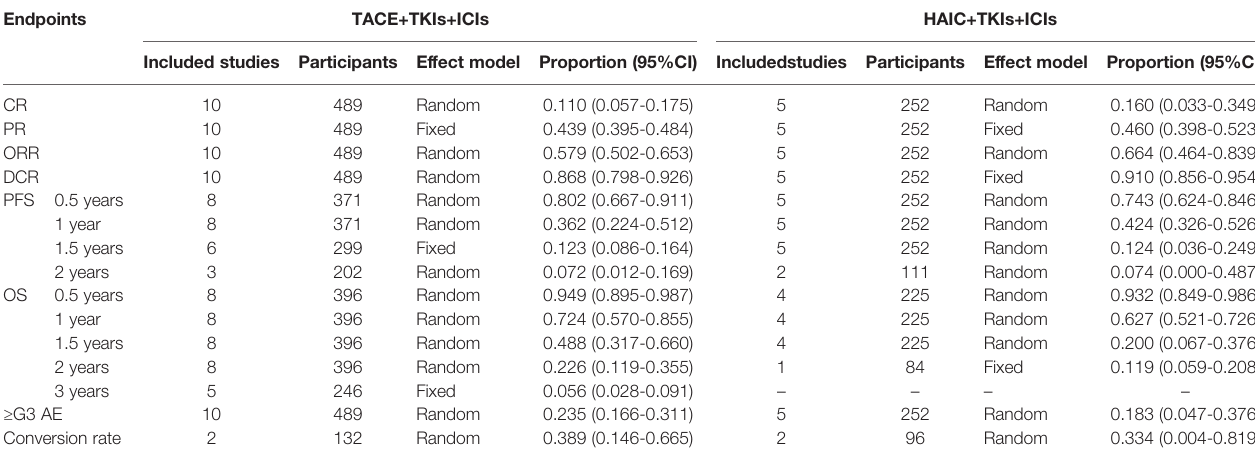
TABLE 4 | Subgroup analysis strati fi ed by TACE or HAIC in triple therapy. Endpoints